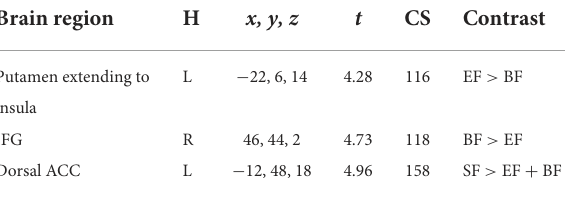
TABLE 2 Study group differences in the resting-state functional connectivity of the medial hypothalamus. Brain